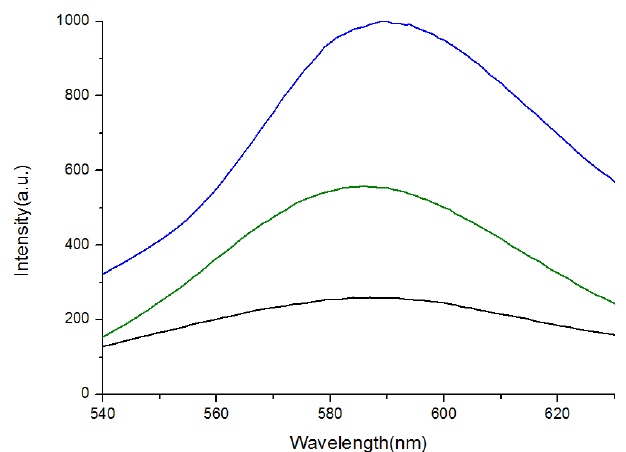
Figure 3. Room temperature solution photoluminescence (PL) emission spectra of the ZnS:Mn-MAA NCs prepared at pH 2 (blue); pH 7 (green); and pH 12